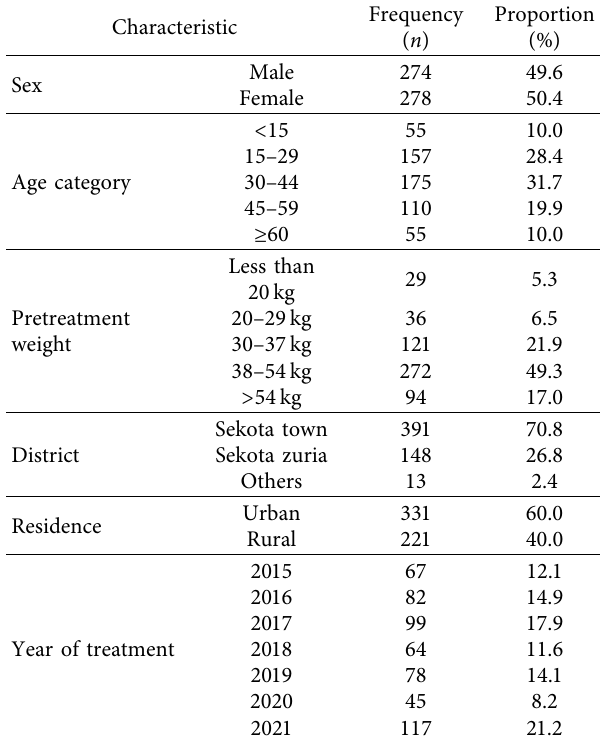
Table 1: Sociodemographic characteristics of TB patients at Tefera Hailu Memorial General Hospital, Sekota town, Northeast